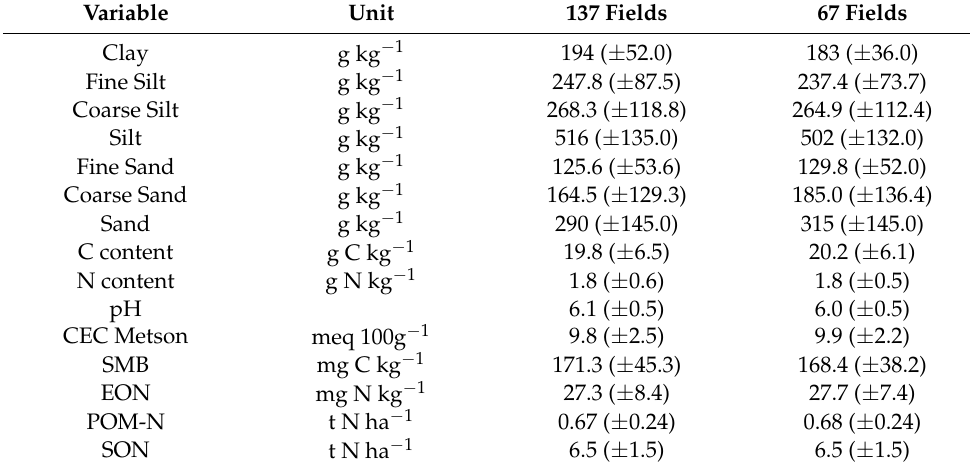
Table 1. Measured mean ( ± 1 standard deviation) soil variables for the 137 fields of the network and the 67 fields selected. Physico-chemical properties of the 0–30 cm soil layer include texture, C and N contents, pH, Metson cation exchange capacity (CEC), soil microbial biomass (SMB), extractable organic N (EON), particulate organic matter (POM-N), and soil organic nitrogen (SON)